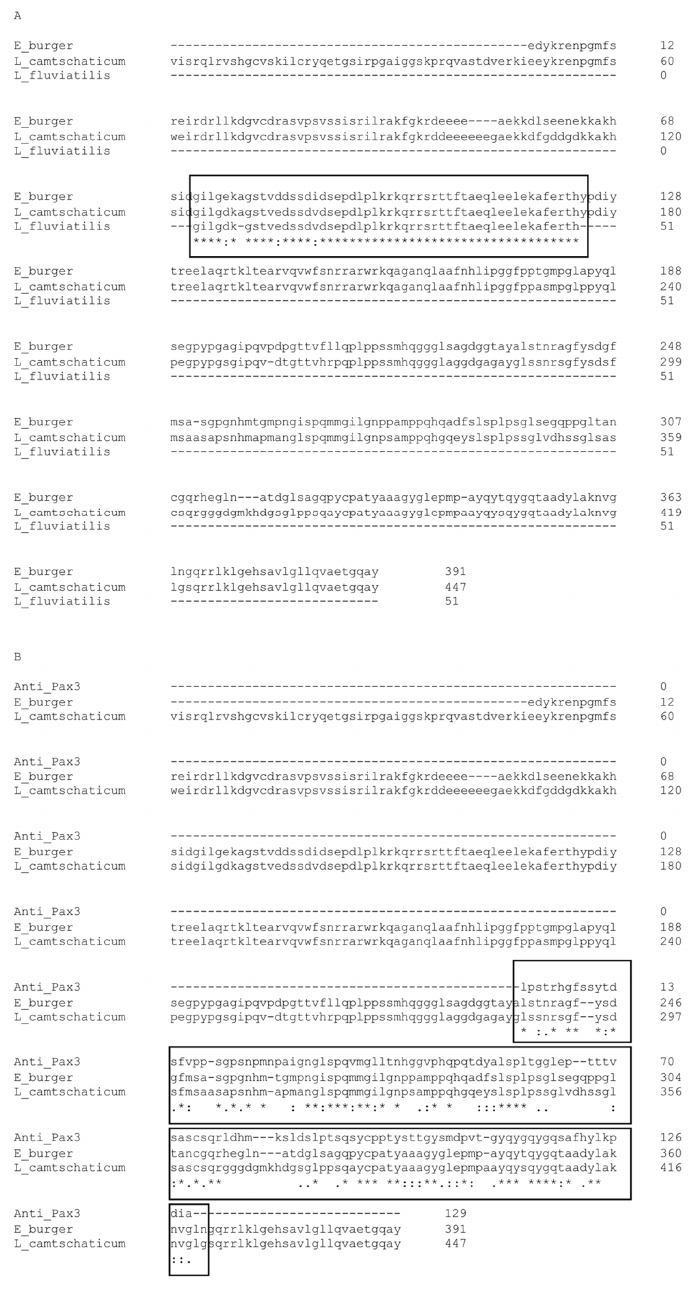
Figure 6. The conserved structure of river lamprey ( Lampetra fluviatilis ) protein LfPax3/7 . ( A ) The aminoacidic sequences alignment of L. fluviatilis LfPax37 (GenBank: AAY90105.1, partial ), Eptatretus burger paired-box protein 3/7 (GenBank: BAG11537.1), and Lethenteron camtschaticum paired-domain tran- scription factor Pax3/7-A (GenBank: ADP37890.1). The black frame shows the homological